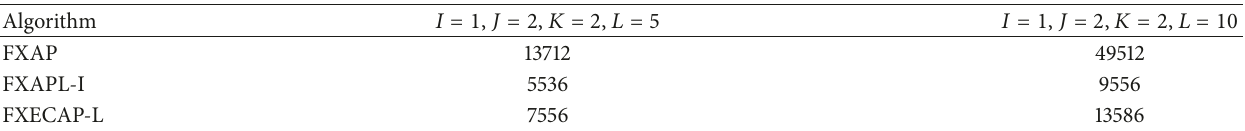
Table 6: Comparison of the computational burden of the FXECAP-L algorithm with those of the FXAP and FXAPL-I algorithms for ANC systems with 𝑁 = 100 and 𝑀 = 128 .